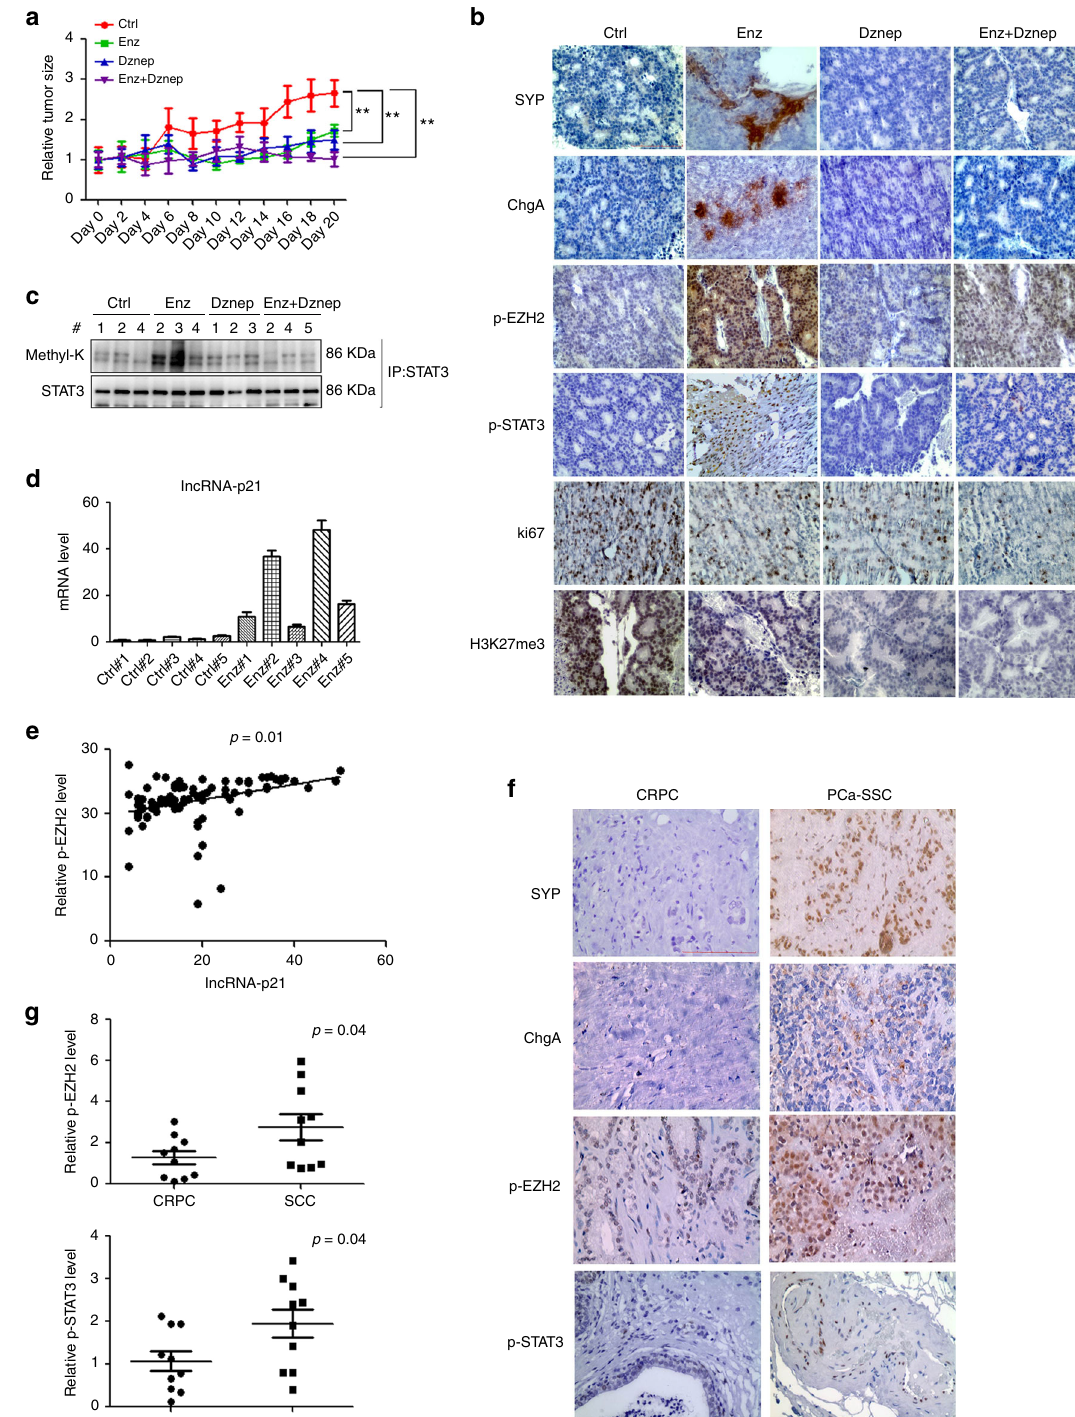
Fig. 8 LncRNA-p21/EZH2/STAT3 signal is activated in PDX mice model after Enz treatment and human NEPC samples. a The PCa PDX samples were subcutaneously implanted into SCID mice and 5 mice/group received different i.p. treatments (1. DMSO; 2. Enz; 3. Dznep; 4. Dznep + Enz) every other day, and tumor sizes were measured after different treatments. After 10 treatments, the mice were kept for another 2 days and then were sacri fi ced.The PDX tumors were collected, and the relative tumor growth rates of different treatments were compared. b The IHC staining to identify the level of NE markers indicated in different groups (Scale bar = 20 μ m). c Three tumor samples were randomly picked up from each group, the tissues were lysed and then STAT3 methylation (methyl-k) was detected by WB. d The lncRNA-p21 levels in control group and Enz-treated group were detected by qPCR. e The correlation of lncRNA-p21 expression and p-EZH2 level in human PCa samples ( n = 80). f Representative images of the immunohistochemistry staining of SYP, ChgA, p-EZH2 and p-STAT3 in human CRPC and SCC samples. (Scale bar = 20 μ m). g The quanti fi cation of p-EZH2 (upper) and p-STAT3 (lower) levels in human CRPC and PCa-SCC samples. For a , e , g , the data are presented as mean ± SD, ** p < 0.005, by t test for two groups or ANOVA for more than two